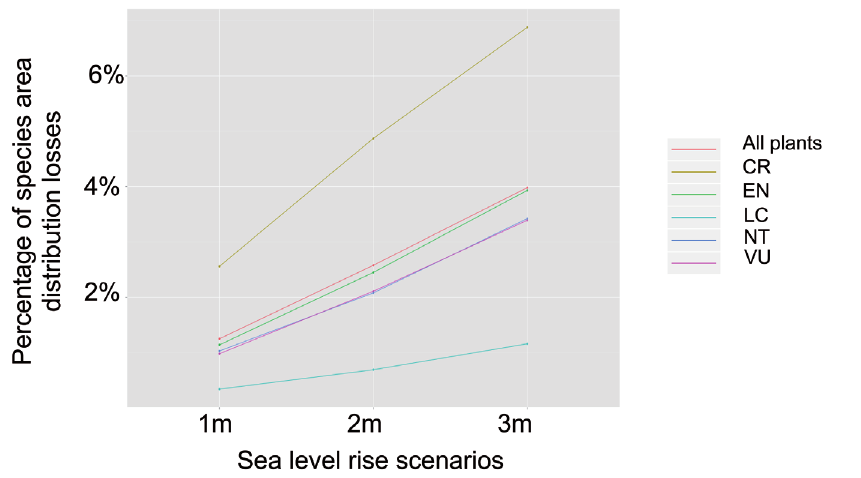
Figure 5. Percentage of species area distribution submerged under 3 different scenario of sea level rise for 64 endemic plants. We grouped the different species according to their IUCN status. CR : Critically endangered, EN : endangered, VU : vulnerable, NT : Near threatened and LC : least